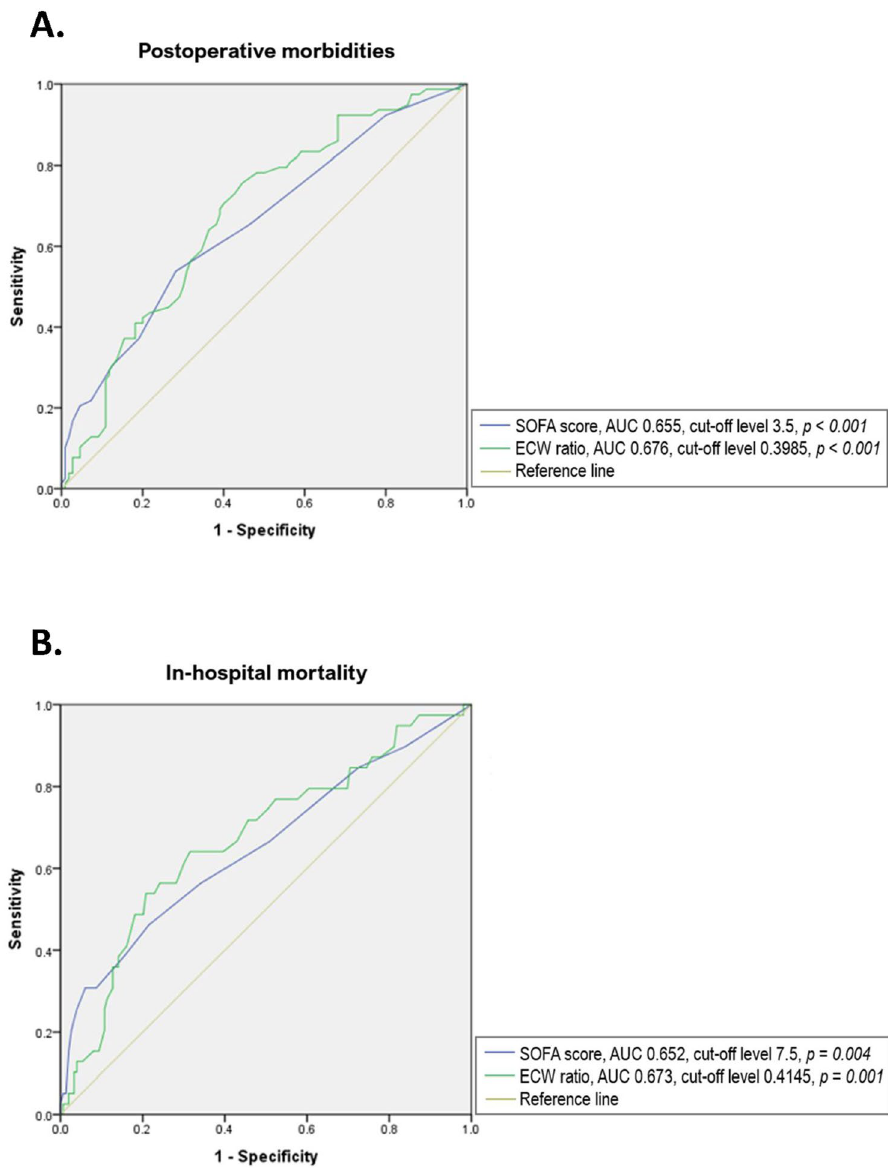
Figure 4. Receiver operating characteristic (ROC) curve analysis establishing cut-off values of SOFA score at ICU admission and ECW ratio at Day 3 to predict the occurrence of ( A ) postoperative morbidities and ( B ) in-hospital